Question: In a single sentence, describe what this figure presents.
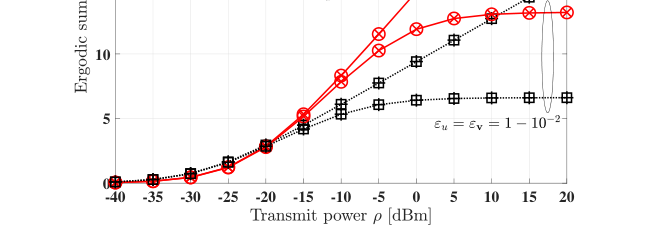
Answer: Theoretical (31), (37) and simulation comparison of the ergodic sum-rate versus the transmit power under different hardware quality factor for the IOS-assisted systems based on the MS protocol and the TS protocol, respectively.